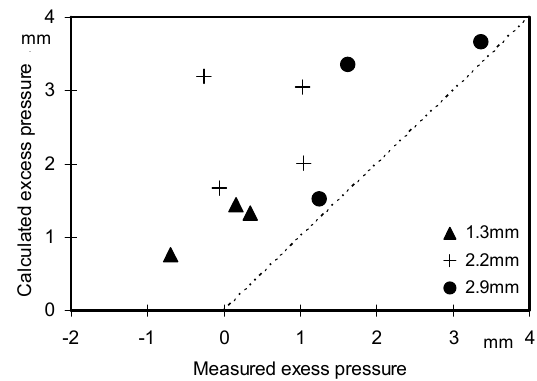
Fig. 7 Velocity profiles for experiments with channel slopes of (a) 13 degree and (b) 17 degree, with 2.9-mm sediment and a 2 L/s water supply.